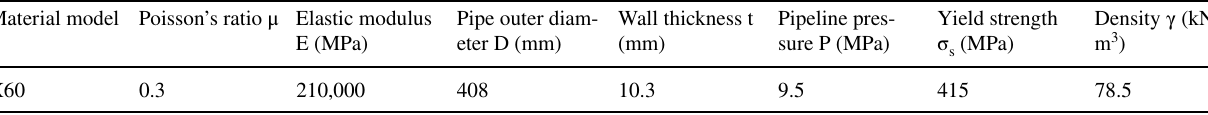
Table 5 X60 pipe specification